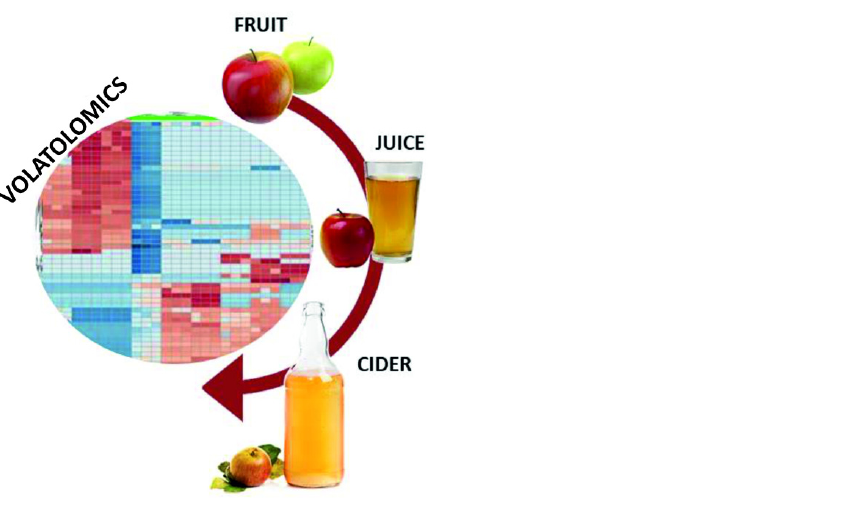
Figure 2. Scheme of VOC biomarkers assessment from the food products. (Adapted from ref. [14]).